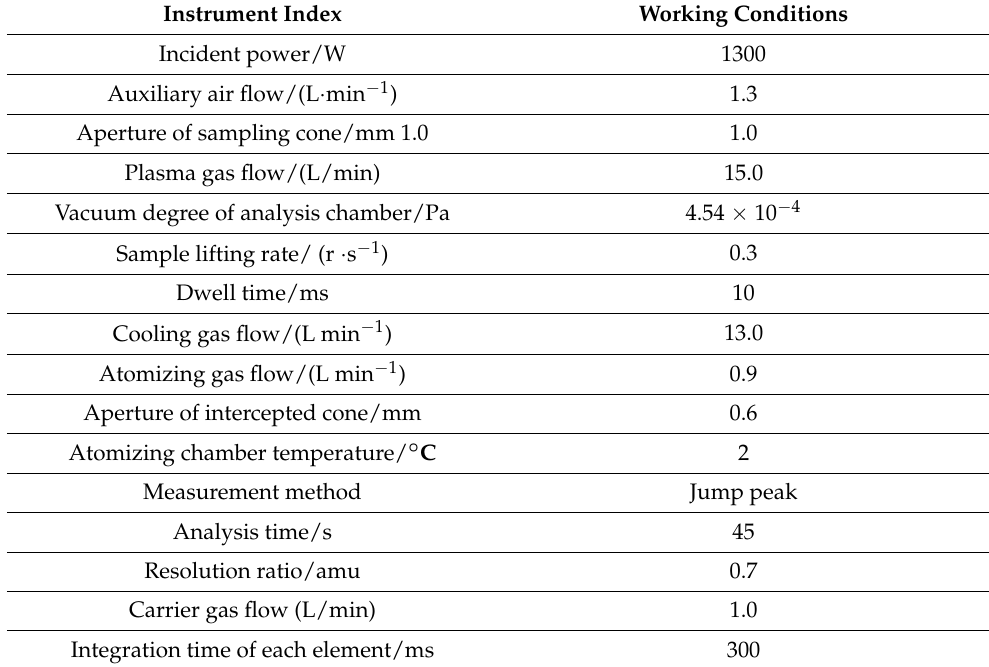
Table 1. ICP-MS operating